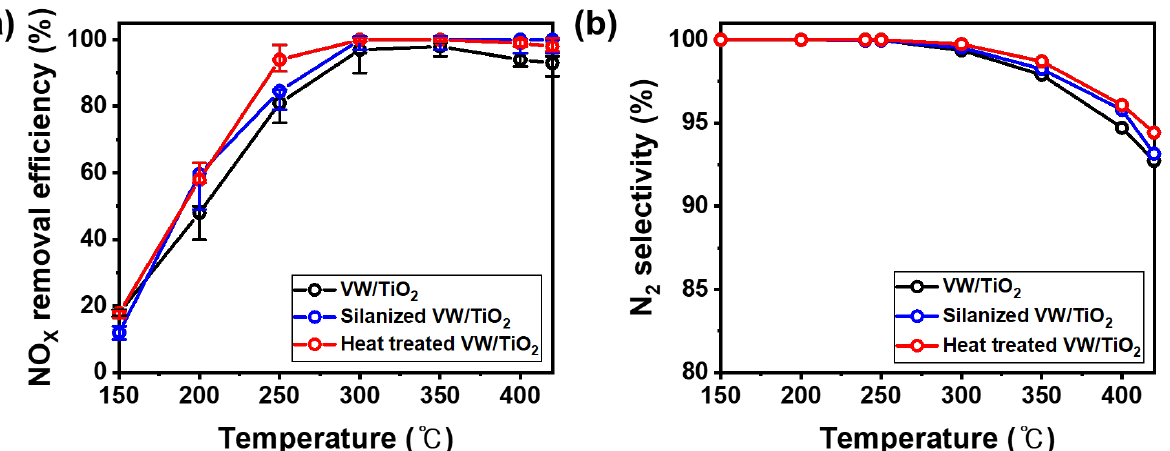
Figure 4. NOx removal efficiency ( a ) and N 2 selectivity ( b ) of V 2 O 5 -WO 3 /TiO 2 (black line), silanized V 2 O 5 -WO 3 /TiO 2 (blue line), and heat-treated V 2 O 5 -WO 3 /TiO 2 (red line). Reaction conditions: [NO] = 300 ppm, [NH 3 ] = 300 ppm, [SO 2 ] = 600 ppm, [O 2 ] = 5 vol.%, and [ gas hourly space velocity ] = 60,000 h −1 .